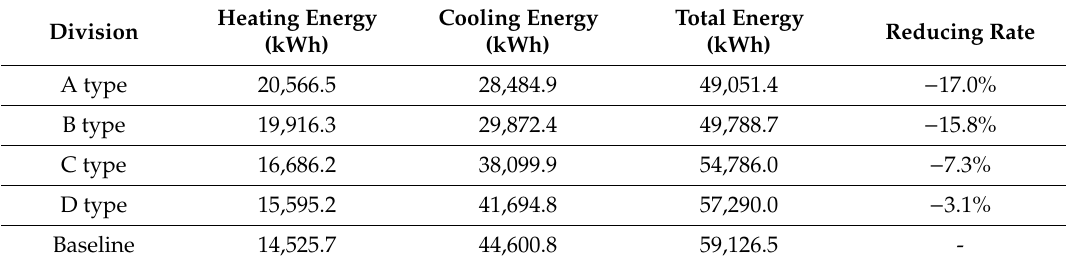
Table 14. Annual building energy analysis result according to glass-attached PDLC film remodeling.